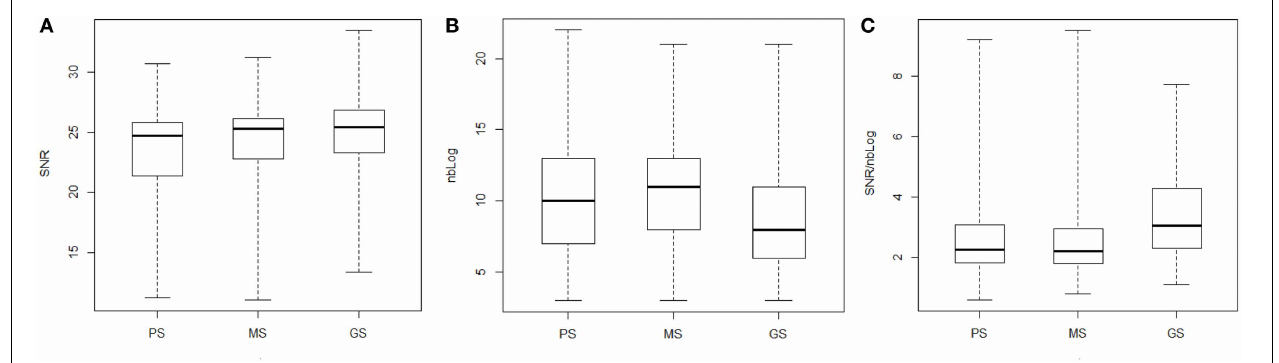
FIGURE 4 | SNR (A), nbLog (B), and SNR/nbLog ratio (C) as functions of the writer class for all